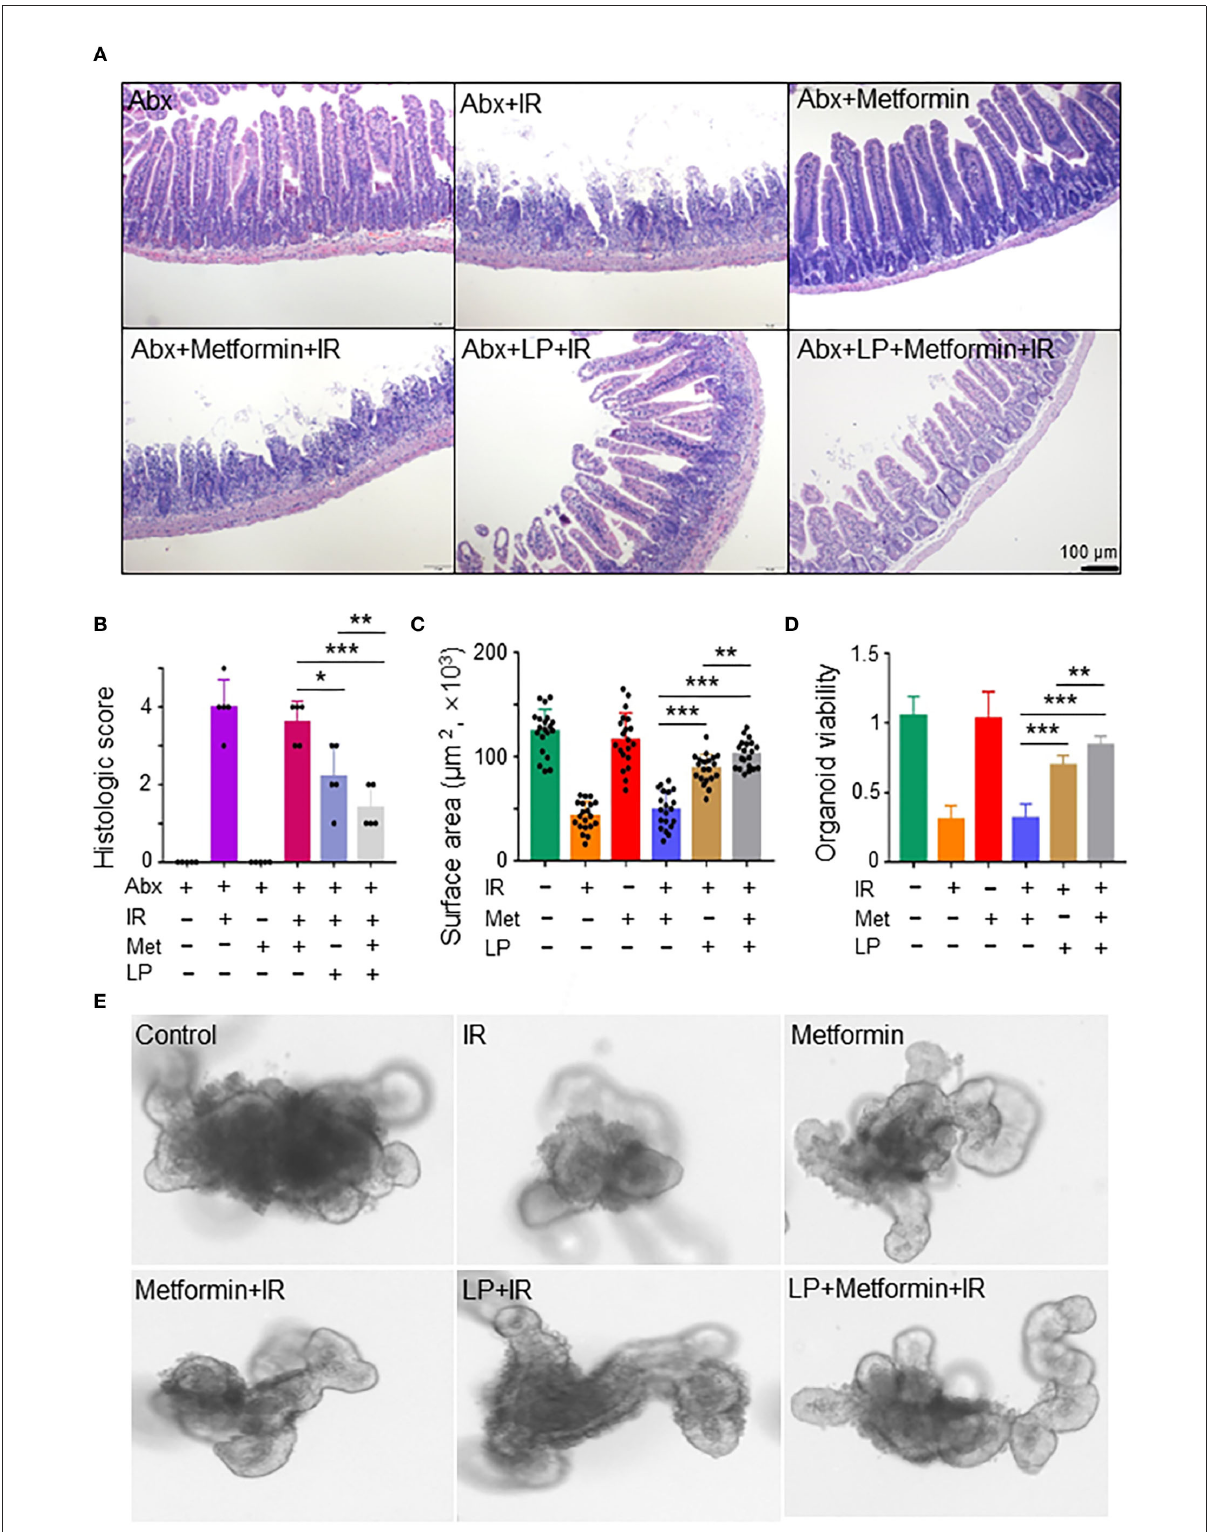
FIGURE5 Metformin protects the murine intestine against IR in the presence of Lactobacillus. (A,B) Mice were pretreated with a mixture of antibiotics for 4 weeks before metformin and/or Lactobacillus treatment. Mice were irradiated as described in Figure 1. Ilea were collected for light microscopy 3 days after IR. (A) H&E staining of ilea. (B) Damage score of ileal tissues. Data represent mean ± SEM. * P < 0.05, *** P < 0.001, n = 5, compared